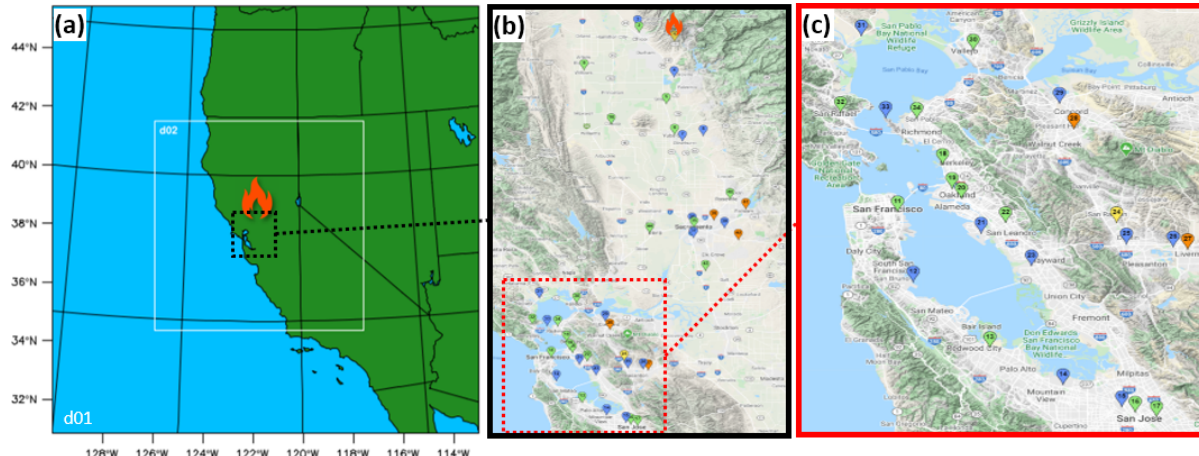
Figure 1. Study domain (a) and observation station locations (b, c) . Domain d01 covers the western US with a horizontal resolution of 8km. Domain d02 is centered over Northern California with a horizontal resolution of 2km. AQS and NCDC observation sites are shown in panels (b) and (c) , where stations marked in green measure only PM 2 . 5 , stations in blue measure wind and temperature, stations in orange measure both PM 2 . 5 and meteorology, and stations in yellow measure temperature only. Additionally, BC and CO are measured at 8 and 12 sites in the Bay Area, respectively. © Google